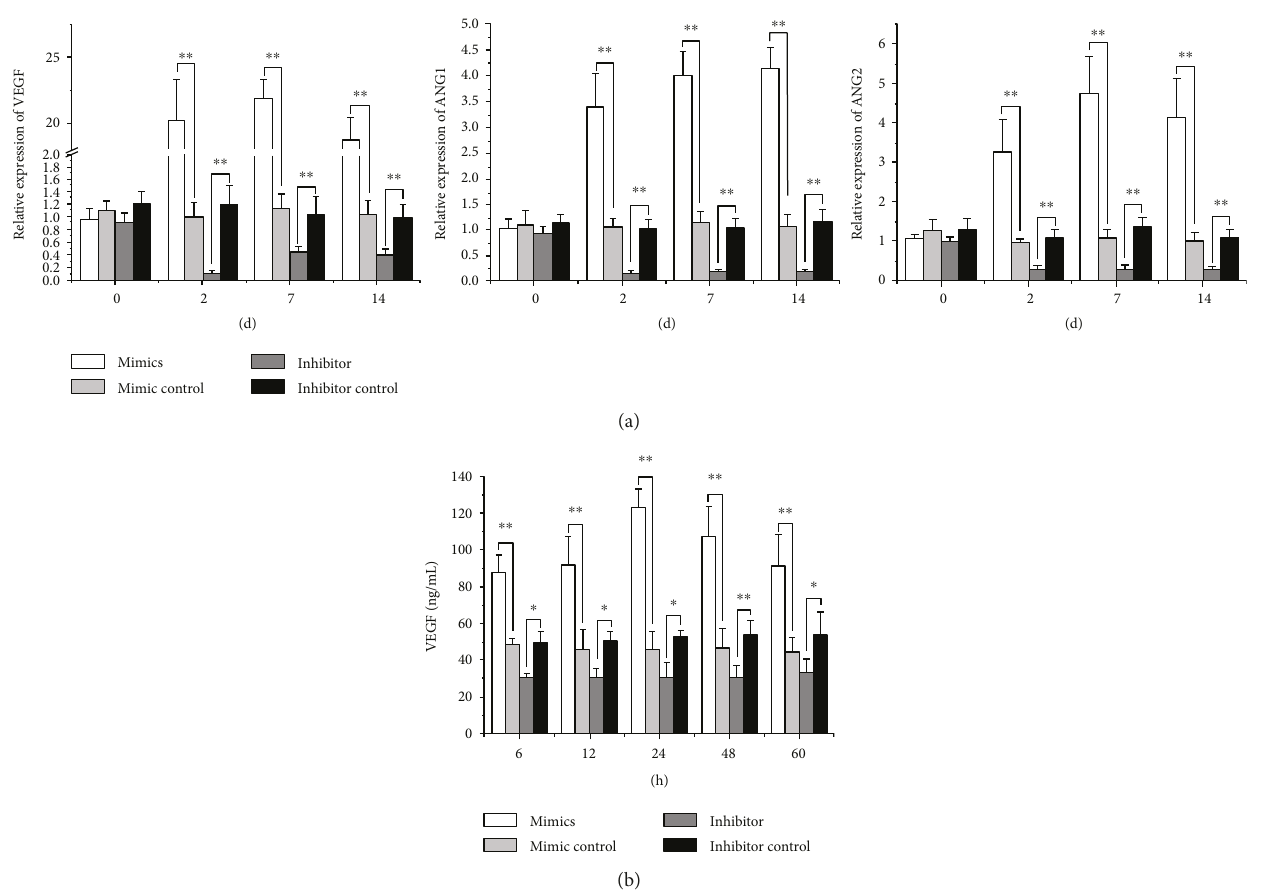
Figure 5: MiR-378 enhanced angiogenesis in vitro. BMMSCs were transfected with miR-378 mimics, miR-378 inhibitor, or the miR-negative control. (a) Angiogenesis gene (Ang1, Ang2, and VEGF) was evaluated by qRT-PCR for angiogenesis enhancement at di ff erent time points after transfection including 2, 7, and 14 days. (b) Overexpression of miR-378 signi fi cantly increased the VEGF protein secretion at 24 h, and levels increased through 60h. ∗ P < 0 05 and ∗∗ P < 0 01 ; n = 3 .